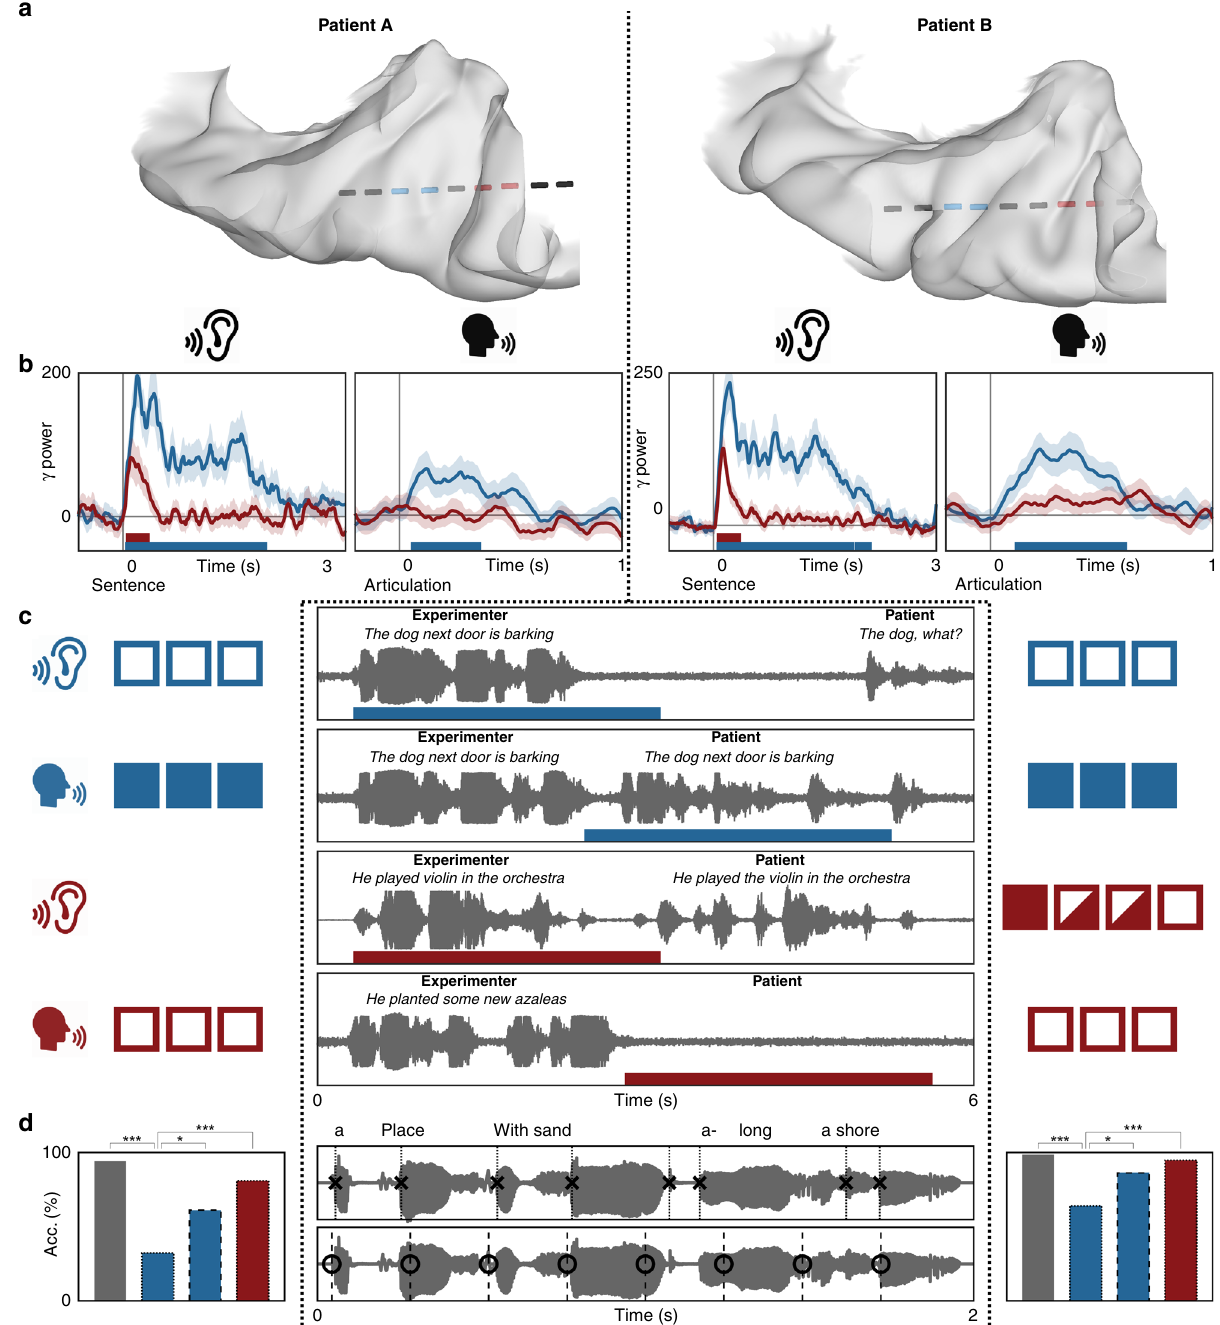
Fig. 9 Chronometric stimulation of the supratemporal plane. Supratemporal responses during two chronometric stimulation experiments. The fi rst patient is shown on the left and the second on the right. a Electrode positions relative to patient-speci fi c neuroanatomy. Two pairs of electrodes localized to HG/ TTS and PT demonstrated sustained (blue) and transient responses (red), respectively. b Average percent change in high-gamma power during auditory naming to de fi nition: sentence listening (left) and articulation (right). The transient response is entirely suppressed during articulation. c Chronometric cortical stimulation mapping with 50 Hz balanced 0.3 ms period square waves for 3 s during sentence repetition. Successful trials are indicated by full boxes, failed trials by empty boxes, and trials with a single error (e.g. word replacement) by half-full boxes. Stimulation was delivered either at stimulus onset (top panel) or offset (middle and bottom panel). The patient was unable to repeat the stimulus when HG/TTS was stimulated during listening, but was unaffected when the HG/TTS was stimulated during production. In contrast, stimulation of PT during production induced failure. d Chronometric stimulation during auditory naming to de fi nition at either acoustic edges (x ’ s; dotted lines) or uniformly distributed times (o ’ s; dashed lines). Baseline accuracies were 94 and 99% (gray bar). Stimulation at acoustic edges in HG/TTS (left blue bar) and PT (red bar) resulted in naming accuracies of 32 and 81% in the fi rst patient and 64 and 95% in the second patient. Stimulation of HG/TTS delivered uniformly throughout the stimulus (right blue bar) resulted in naming accuracies of 61 and 86%. Signi fi cant differences between binomial distributions were evaluated via z statistic (* p < 0.05, ** p < 0.01, *** p <